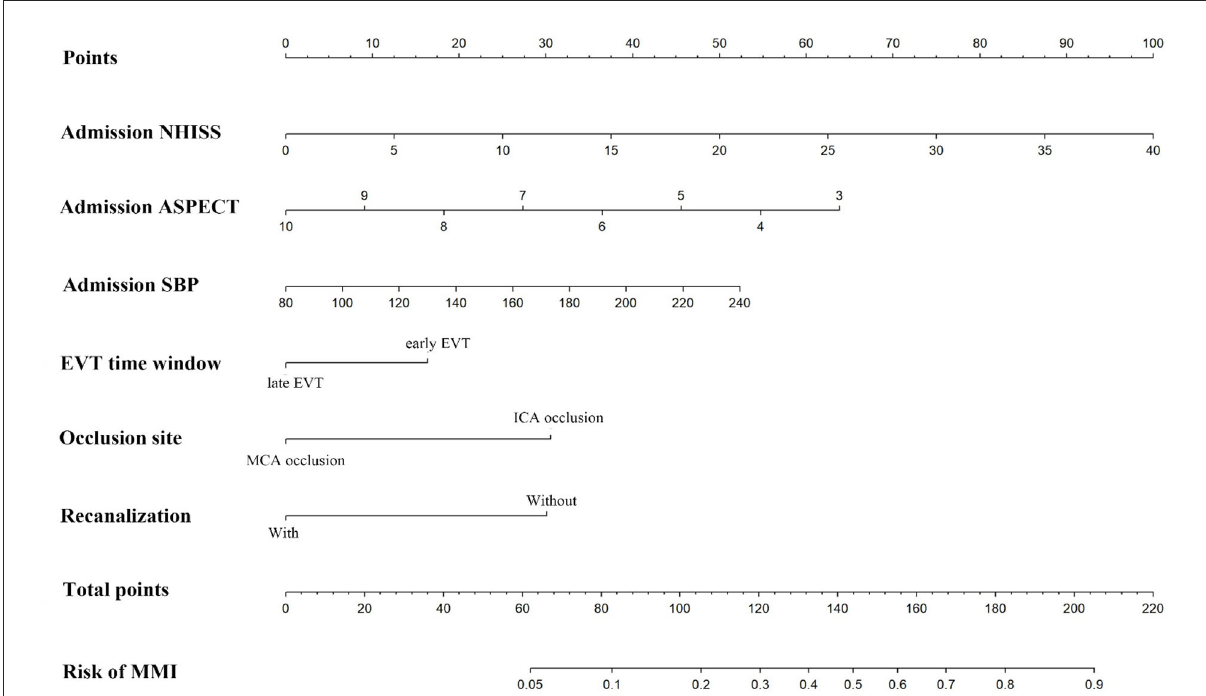
FIGURE2 The nomogram for predicting the probability of malignant middle cerebral artery infarction. NIHSS, National Institute of Health Stroke Scale; ASPECTS, Alberta Stroke Program Early Computed Tomography Score; SBP, systolic blood pressure; EVT, endovascular therapy; ICA, internal carotid artery; MCA, middle cerebral artery; MMI, malignant middle cerebral artery infarction.